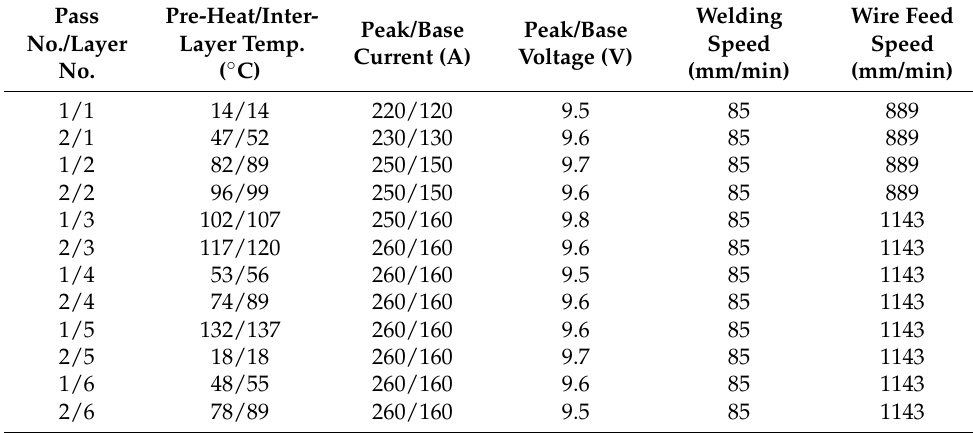
Table 6. Welding process parameters used for each pass of the weld joint.